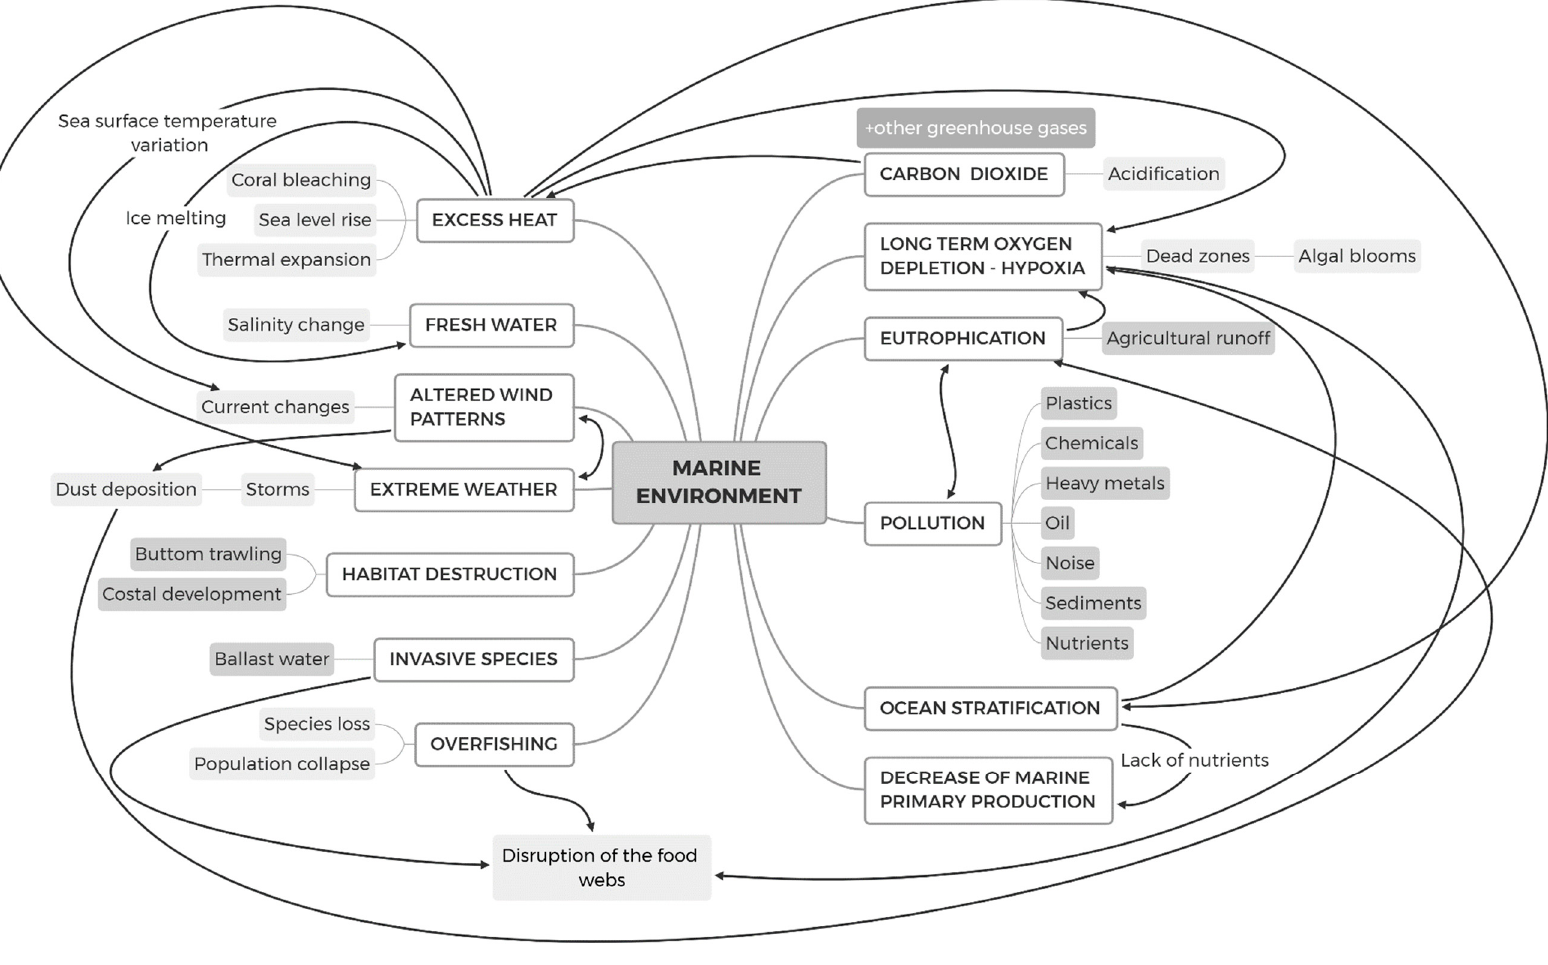
Figure 2. Mind maps of known stressors in the marine environment and their possible interactions.